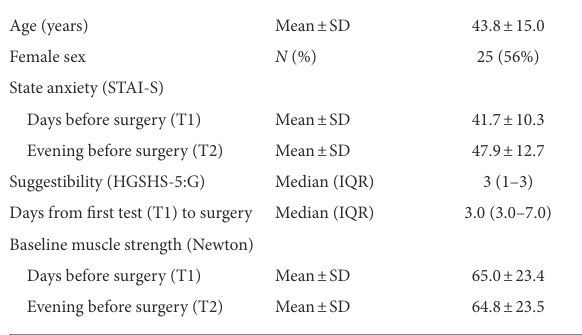
TABLE 2 Baseline characteristics of study population (N =